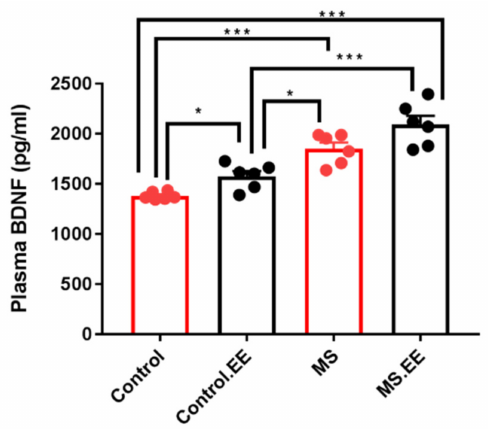
Figure 4. Effects of maternal separation and EE on plasma brain derived neurotrophic factor (BDNF) levels. * p < 0.05, *** p < 0.001. n = 6 in each group. Data are presented before log-transformation, MS: Maternal Separation, EE: Environmental